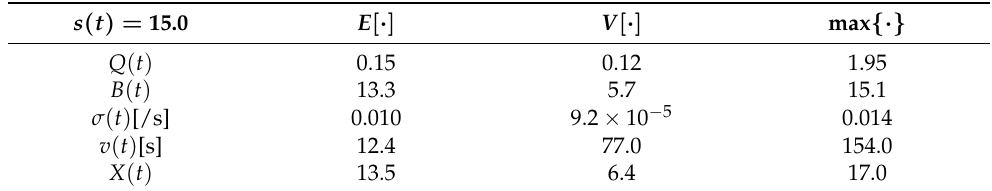
Table 2. Representative values of functions in the actual terminal airspace.